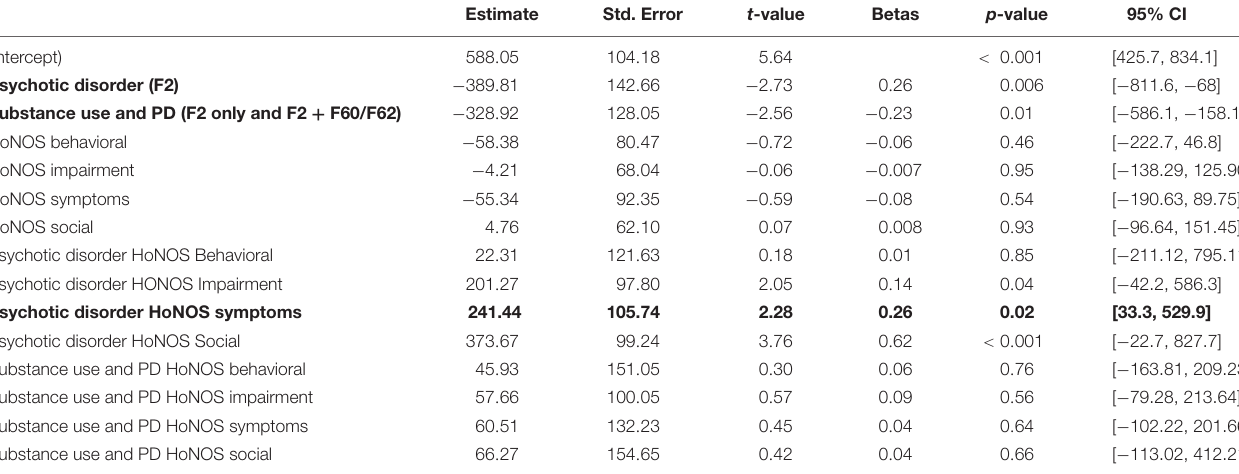
TABLE 3 | Effect of interaction between HONOS subscales and diagnosis on the length of stay. Estimate Std. Error t -value